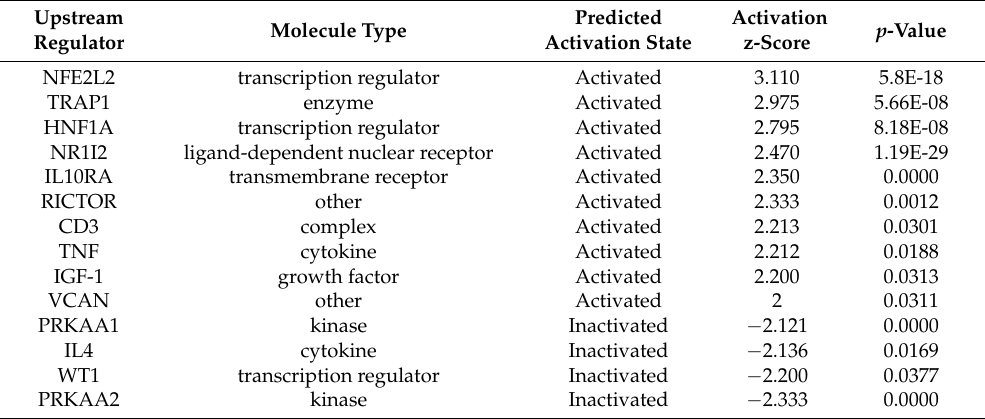
Table 4. List of upstream regulators activated and downregulated in liver tumors of TSOD mice detected by